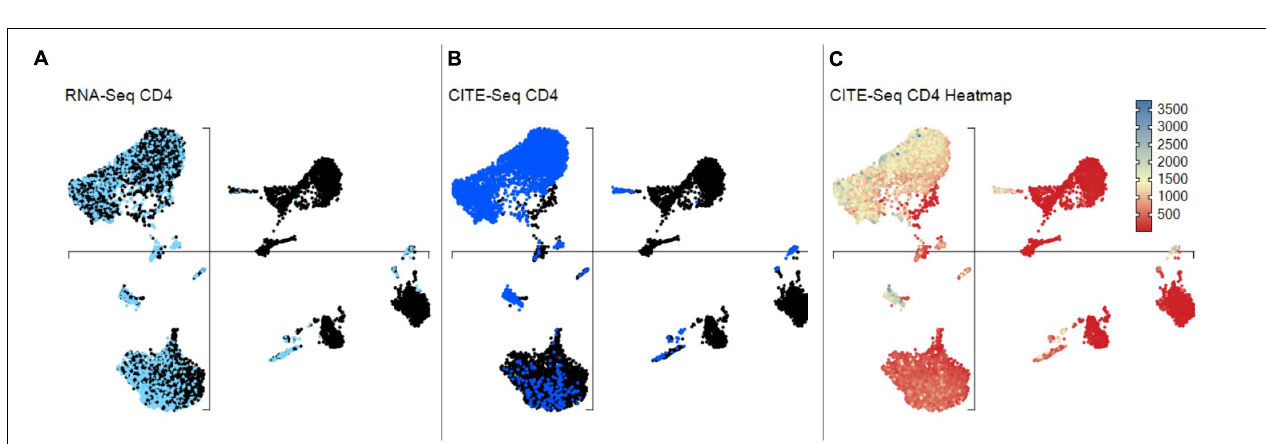
FIGURE 11 | Overlay of surface protein expression (scCITE-seq) onto scTCR–RNA-seq analyses. Within the “RNA-seq plot viewer options” window, normalized CITE-seq data are included in the “Metadata” panel, accessible via the dropdown tab (highlighted red). All applications discussed for scRNA-seq analyses are applicable to protein with differential analyses between groups, selection into groupings or dissection via the “cell/sample metadata/domain. Depth bar (highlighted red) provides detail of protein expression density via a white-to-black scaling with darker areas representing most abundant expression.